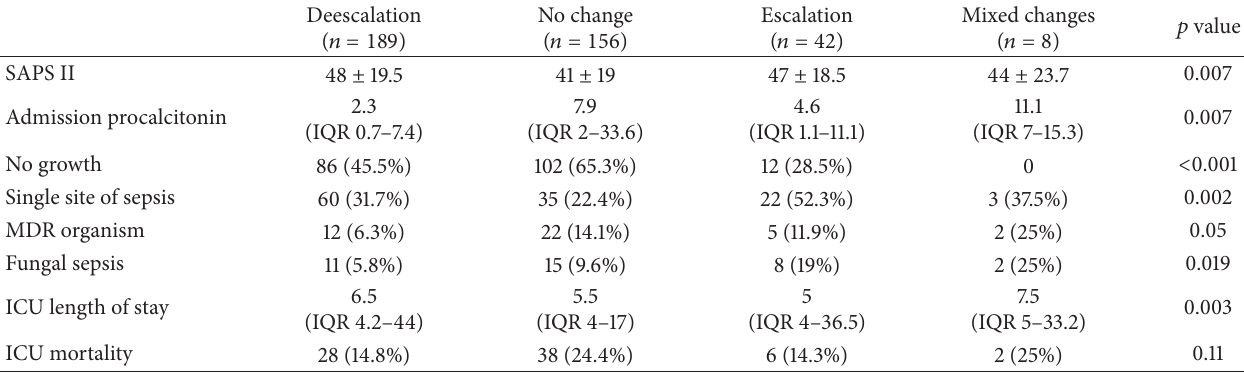
Table 3: Differences in patient characteristics by final antibiotic grouping.